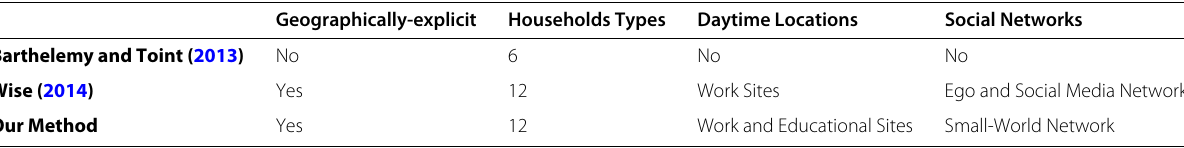
Table 1 Various synthetic population methods: adaptions and